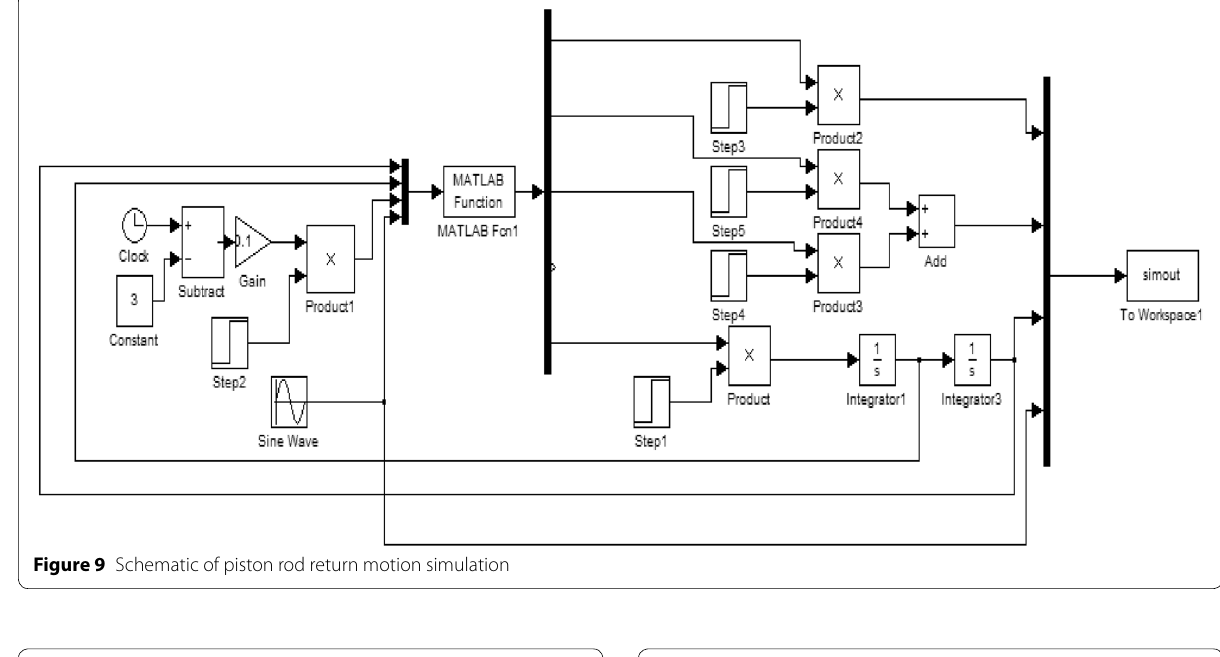
/sThe radial force on the piston rod The force between the piston rod and the cylinder The asymmetric support force